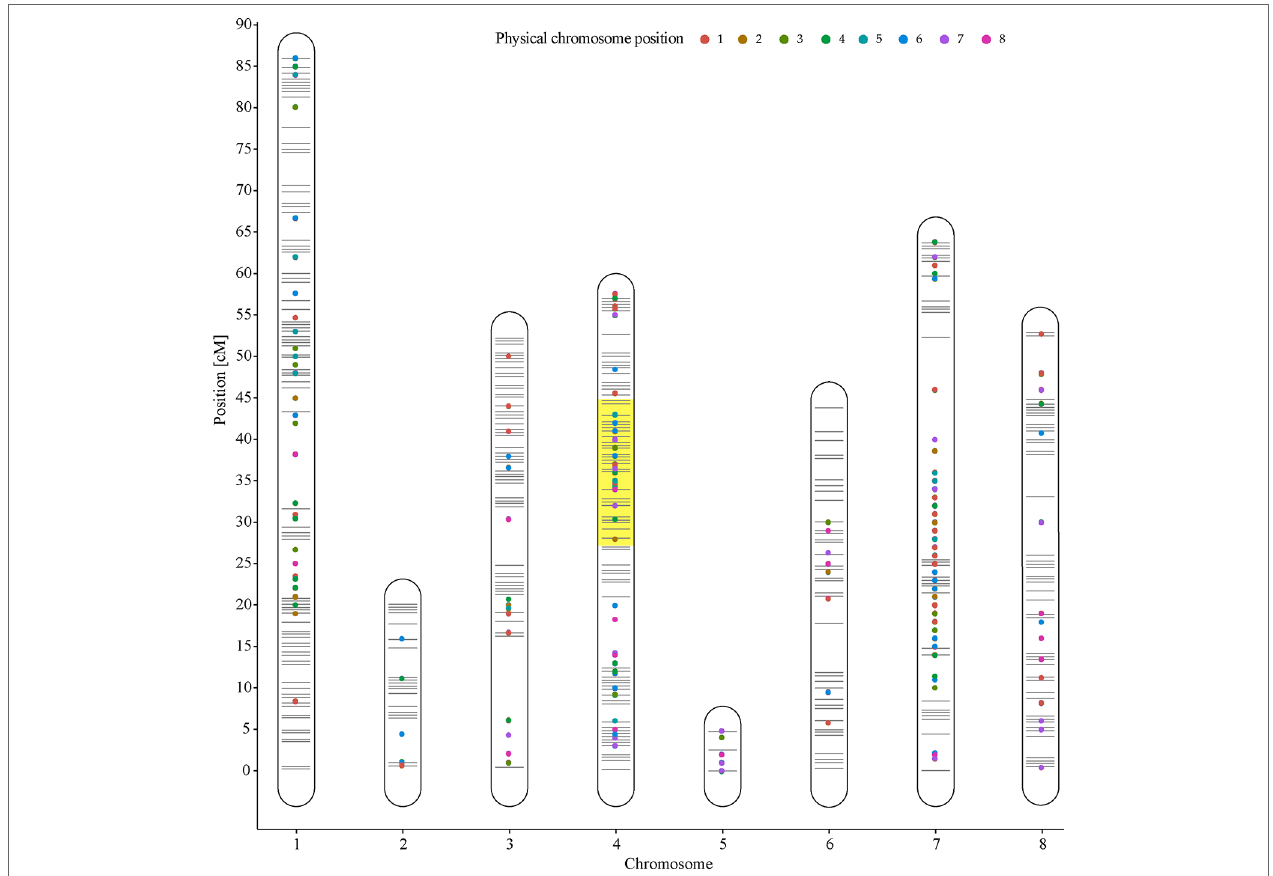
FIGURE 5 | Expression QTLs (eQTL) distribution on Venus × Venus genetic linkage map. Lines represent eight chromosomes of peach. The co-localization of eQTLs (LOD score >5) on qP-SOR4 is highlighted in